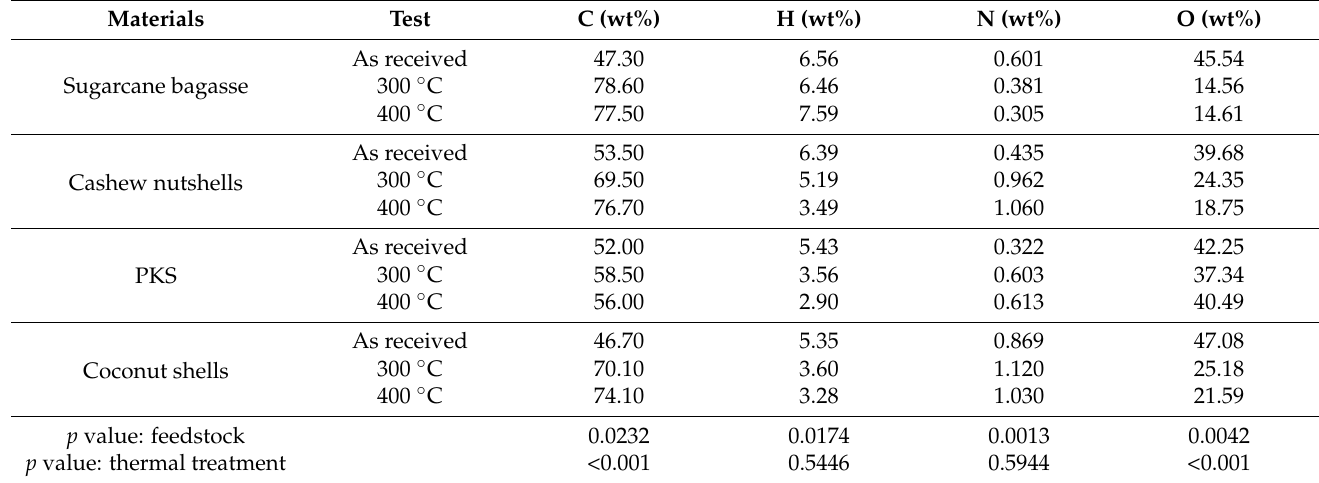
Table 2. Results obtained in the elemental analysis (average values